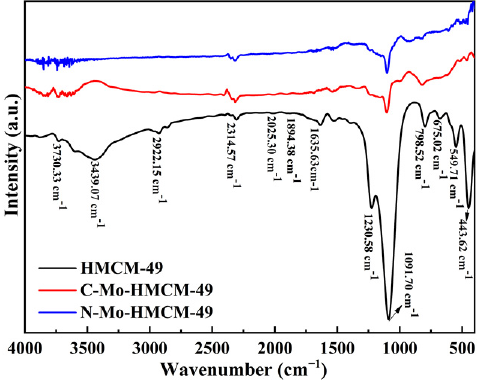
Figure 4. FT-IR spectra of HMCM-49, C-Mo-HMCM-49 and N-Mo-HMCM-49.